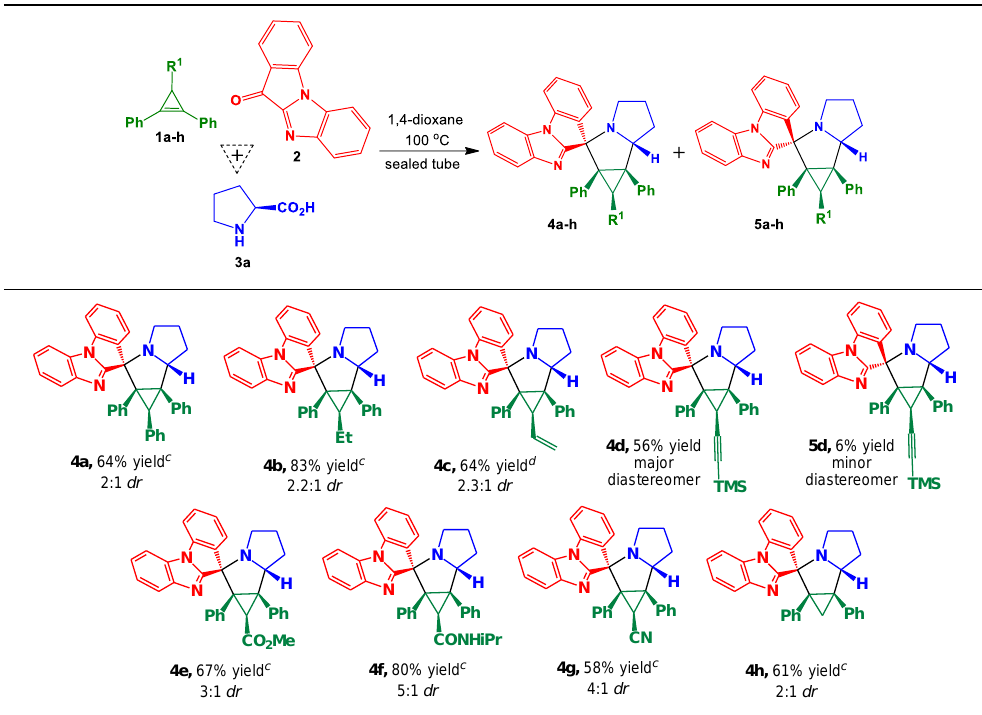
Table 2. Synthesis of Racemic Spiro-Adducts 4 via One-Pot Three-Component Reactions of Cyclo- propenes 1a-h, Ketone 2 and L -Proline (3a) a,b,e.